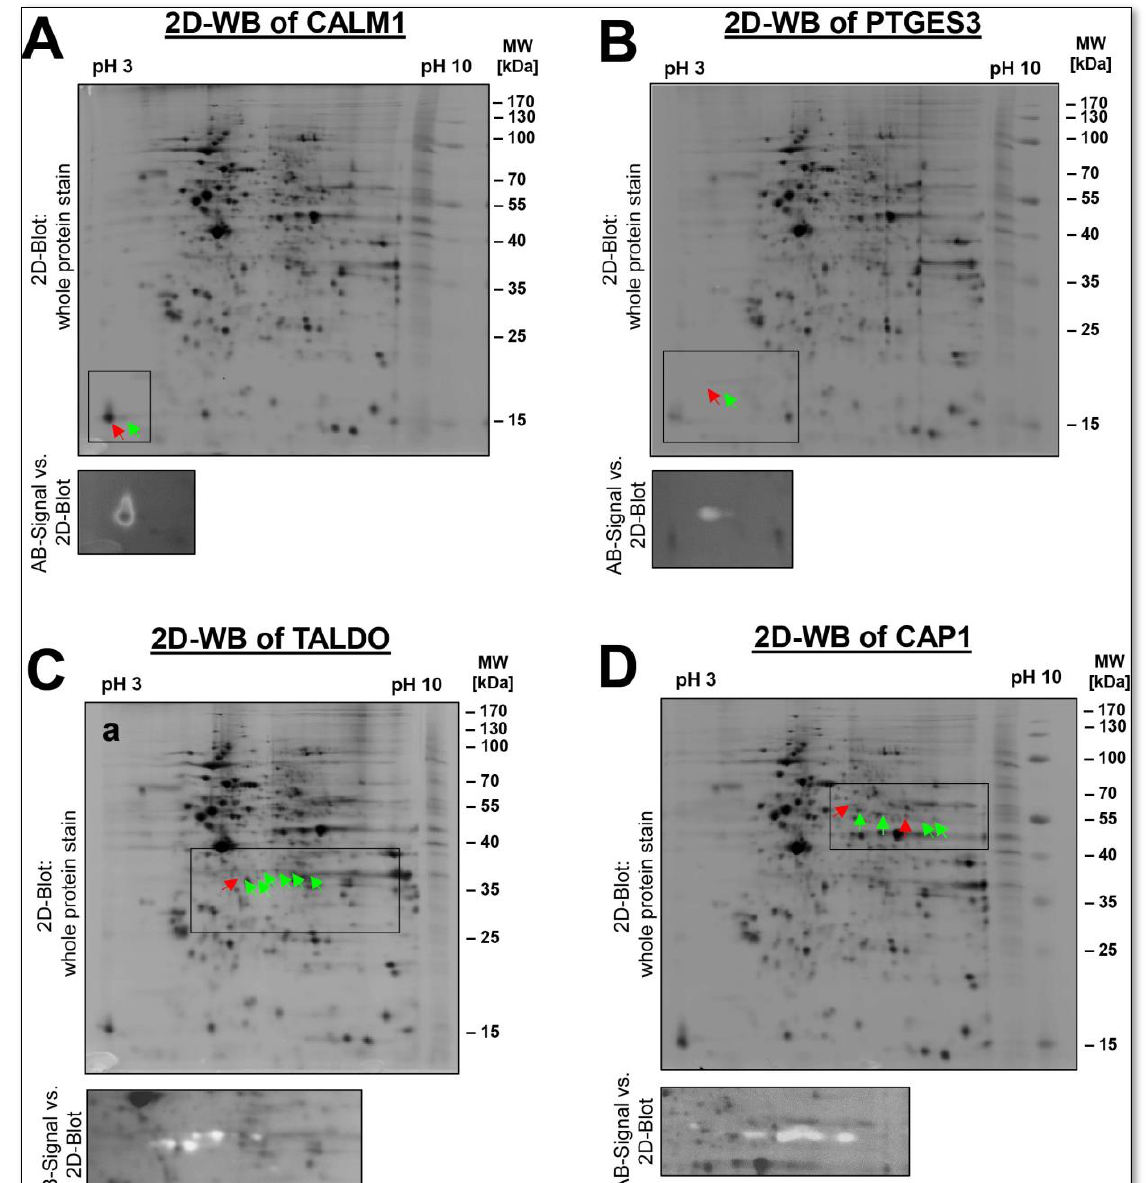
Figure 10. Two-dimensional WB confirmation of ʎ -PPase treatment sensitive proteins CALM, PTGES3, TALDO and CAP1. With IEF, 30 µg of Cy5-labeled DU145 protein lysate were separated on a 7 cm IPG strip, pH 3 – 10, followed by molecular weight separation by 11.5% SDS-PAGE and blotted onto a PVDF membrane. The 2D-WB membranes were scanned with a laser scanner at 650 nm wavelength and shown as black spots. The 2D-WB images of the Cy5-stained proteomes are stained with antibodies against ( A ) CALM1, ( B ) PTGES3, ( C ) TALDO and ( D ) CAP1 and the specific signals are visualised by secondary HRP-conjugated antibodies and chemiluminescence (white spots). Overlays indicate the particular Cy5- labelled spots in black spots and specific antibody sig- nals with white spots. Red arrows indicate phosphorylated protein spots, and green arrows indicate non-phosphorylated protein spots. Abbreviations: 2D-DIGE — two-dimensional difference gel elec- trophoresis; IEF — isoelectric focusing; IPG — immobilised pH gradient; WB — western blot; MW — molecular weight; pI — isoelectric point; ʎ -PPase — lambda phosphatase. Supplementary Figure S4. Abbreviations: 2D-DIGE—two-dimensional difference gel